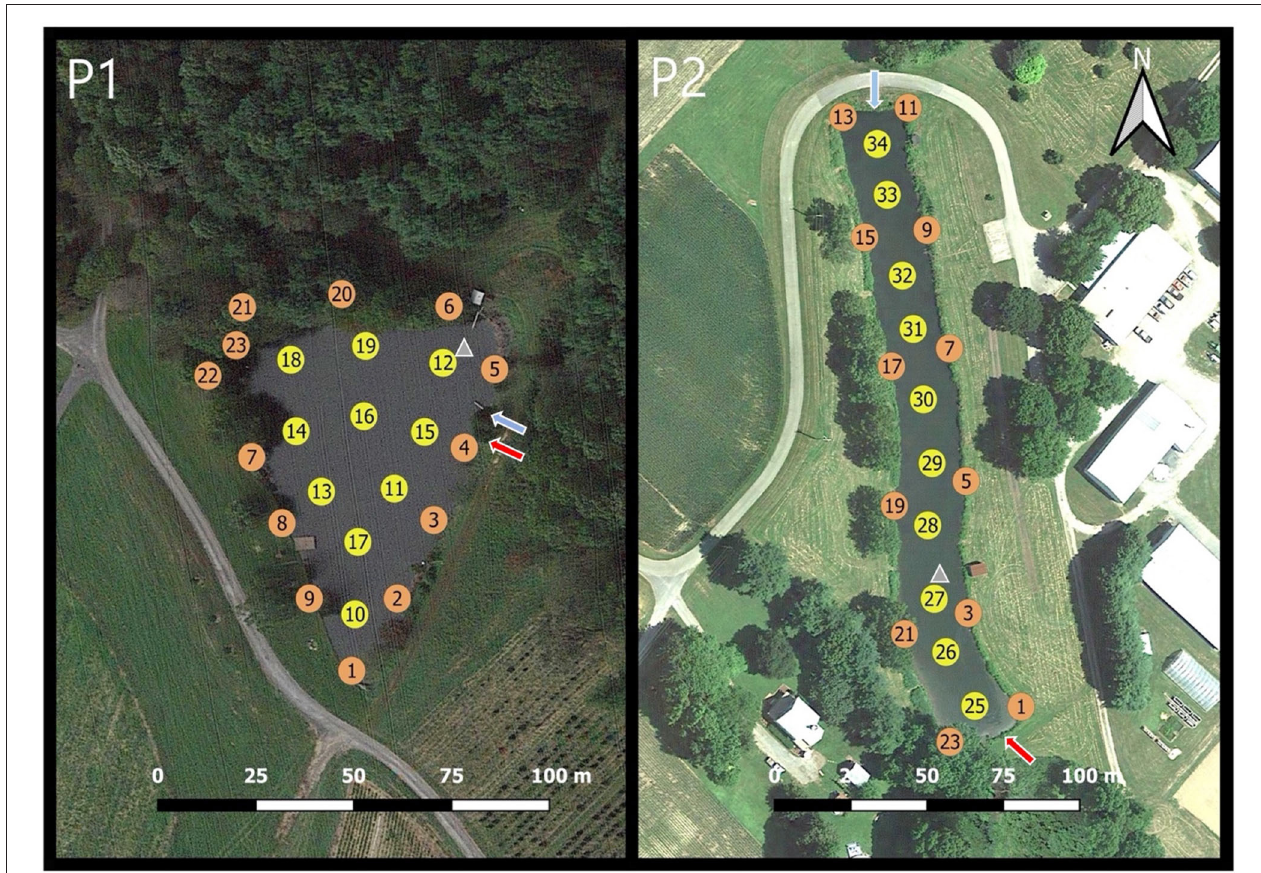
FIGURE 1 | Sampling locations for both Pond 1 (P1) and Pond 2 (P2). Station location number is stated inside the circle. Yellow circles indicate interior water sampling locations and orange circles indicate nearshore sampling locations. Blue arrows represent inflow points and outflows are represented by red arrows. Irrigation intake is represented by a gray